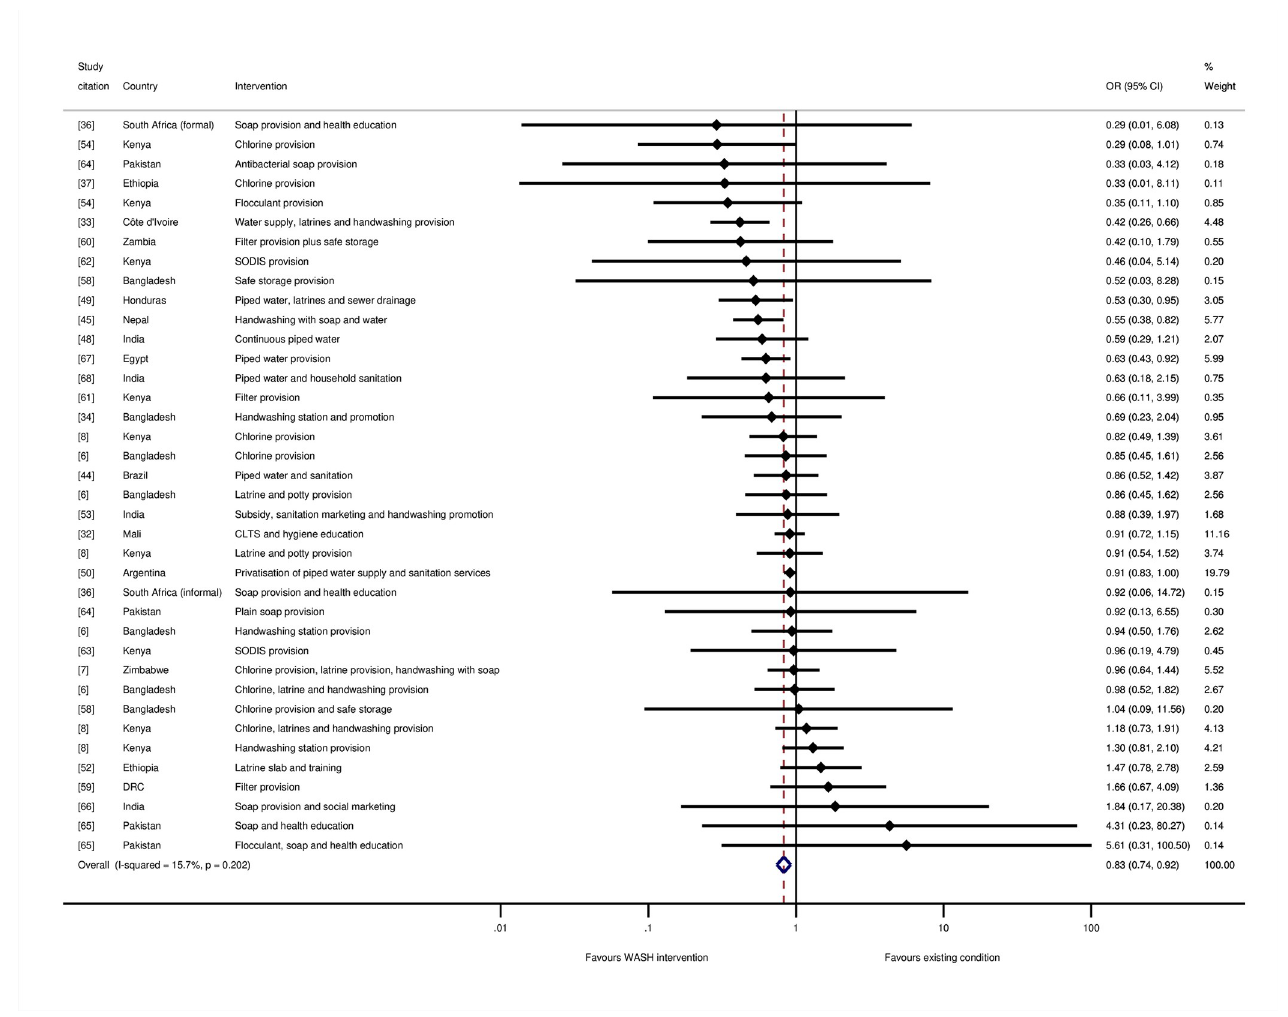
Fig 4. Effects on all-cause mortality in childhood of WASH